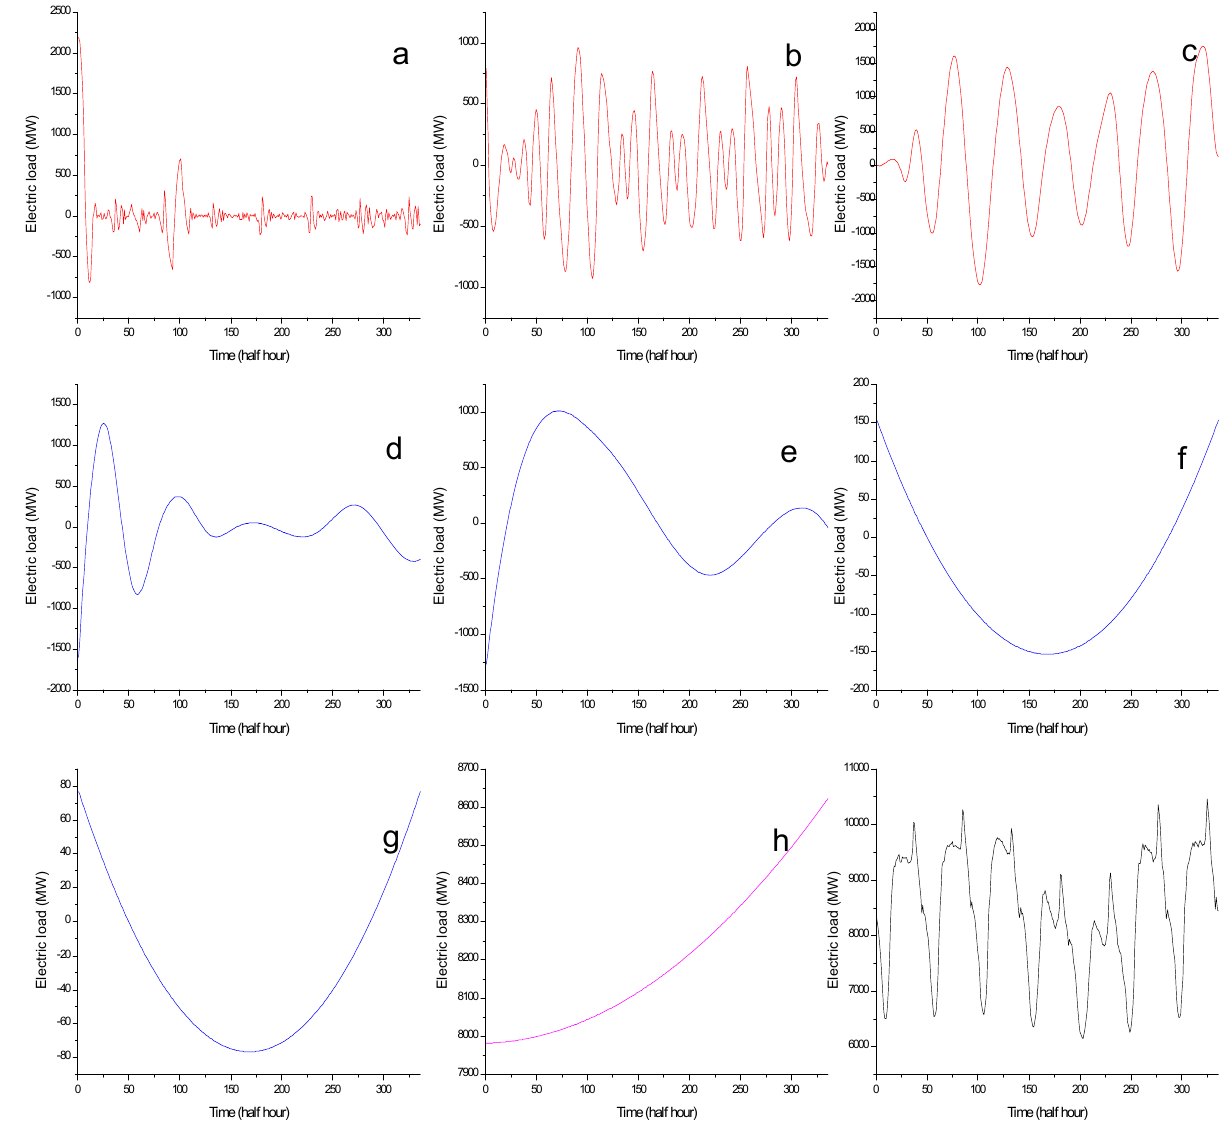
Figure 4. For ease of prevention, the graphs ( a – h ) show our section of plots at different IMFs for the small sample